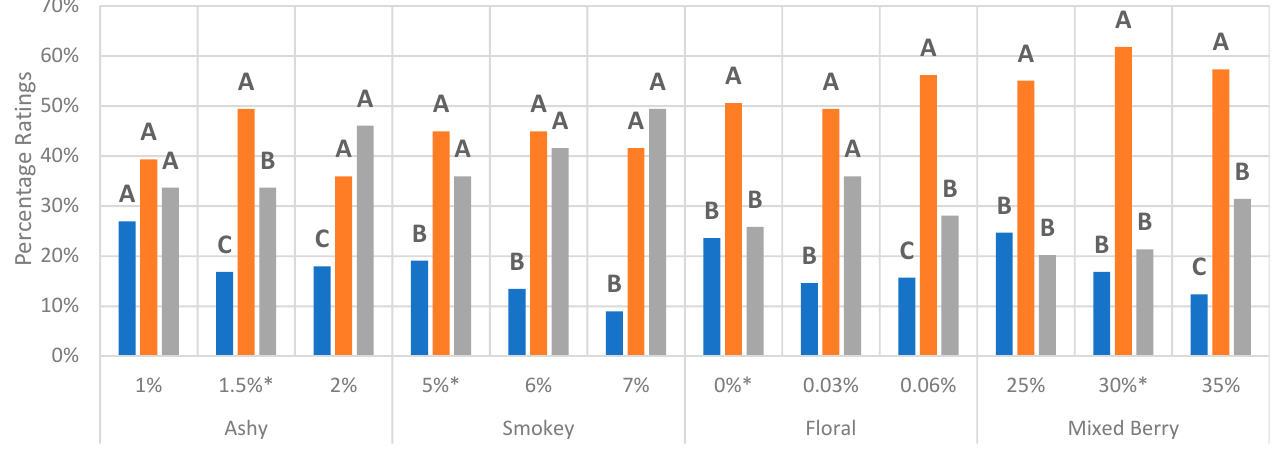
Figure 1. Percentage of ratings above (grey), below (blue), and at JAR (orange). The same letter above bars indicates statistical similarity between groups within each sample ( α = 0.05), as determined by a two-sample proportion test. * indicates optimal % for reference; see Table 1 for % information.